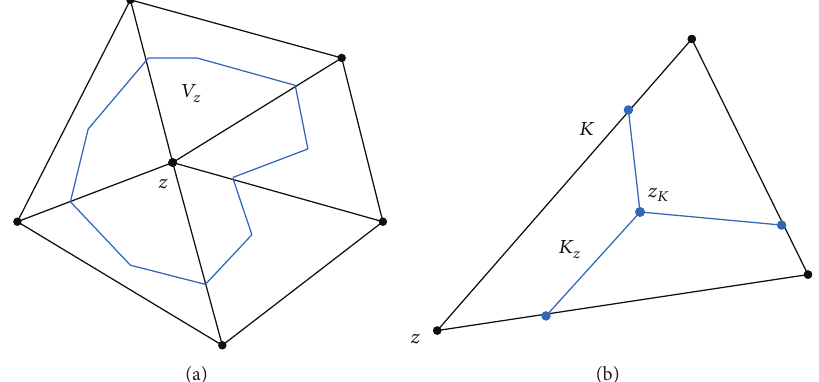
Figure 1: (a) A sample region with blue lines indicating the corresponding control volume 𝑉 𝑧 . (b) A triangle 𝐾 partitioned into three subregions 𝐾 𝑧 .